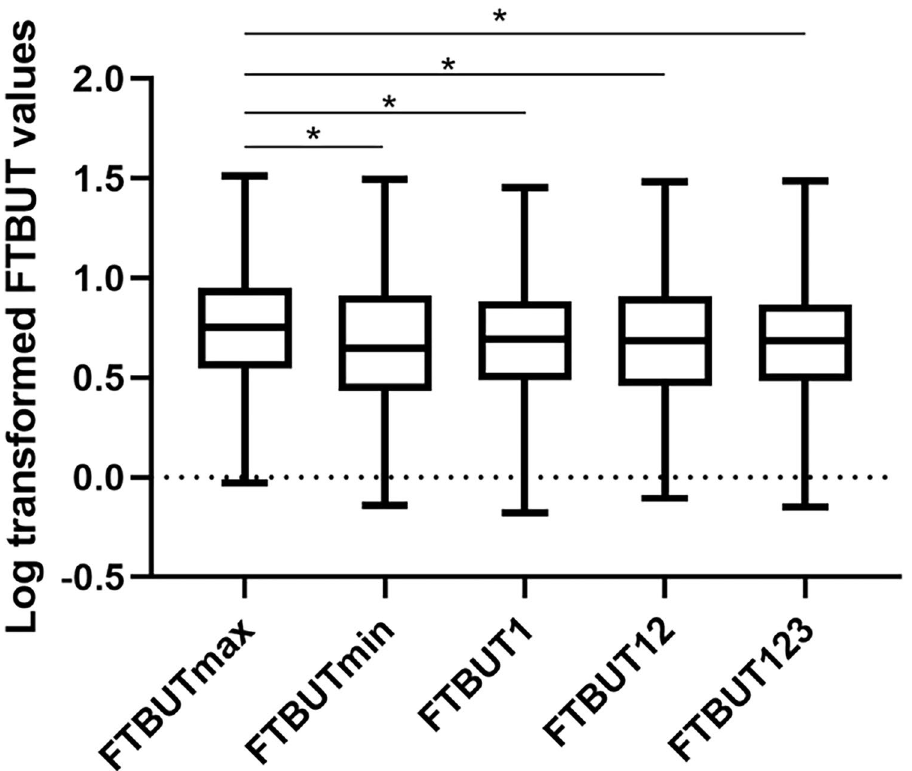
Figure 1. Boxplots of median (95% CI) for the comparison of logarithm transformed FTBUT1, FTBUTmax, FTBUT123, FTBUT12 and FTBUT23 values using one-way ANOVA test. Significant difference was found between FTBUTmax and FTBUT1, FTBUT123, FTBUT12, FTBUT23 respectively ( p = 0.034, 0.038, 0.040 and 0.025, respectively) while no difference was found among other four FTBUT values. * p <